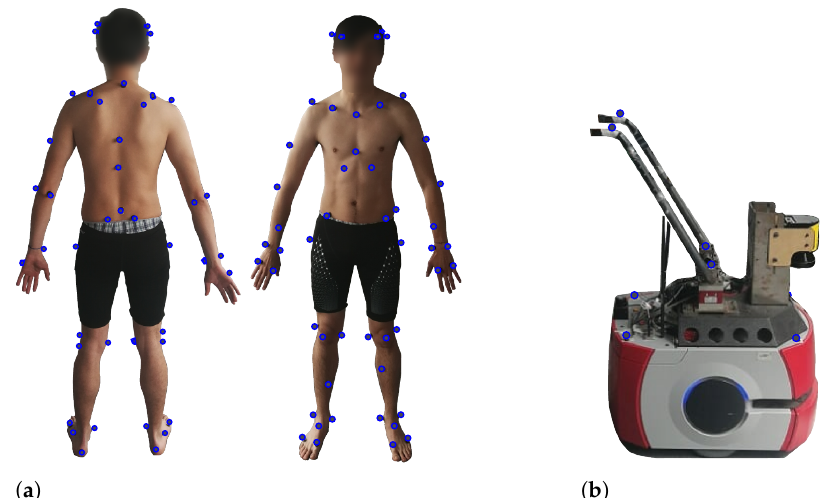
Figure 3. ( a ) Markers’ setup on subject. ( b ) Markers’ setup on the SW.